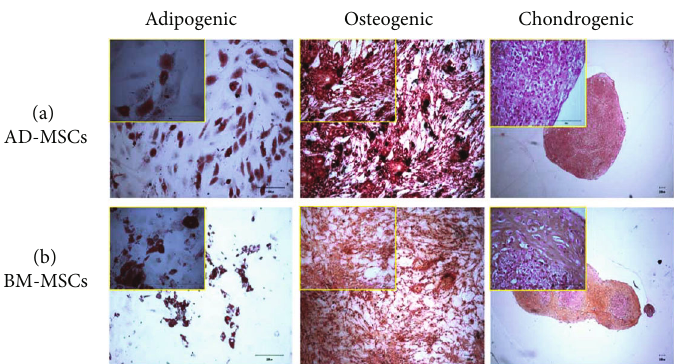
Figure 2: Trilineage di ff erentiation potential of primary for (a) AD-MSCs and (b) BM-MSCs in adipogenic di ff erentiation, osteogenic di ff erentiation, and chondrogenic di ff erentiation.